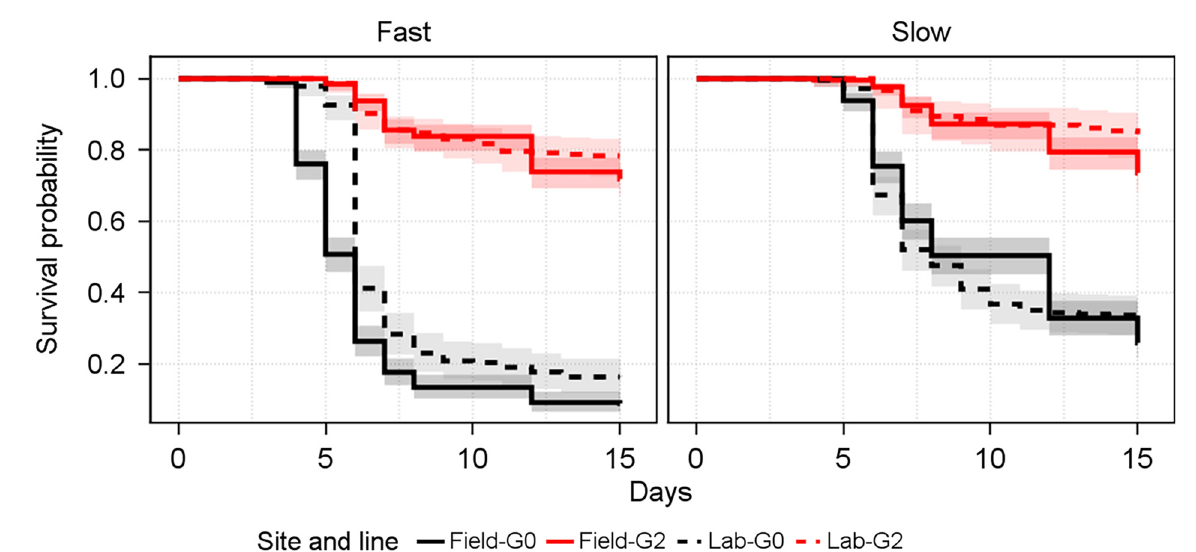
Fig. 7. Survival probability of oysters exposed to OsHV-1 under field or laboratory conditions as a function of growth rate (fast and slow) and line (G0 and G2). Values are means ± 95% confidence intervals (n = 2−3 tanks or oyster bags). G: